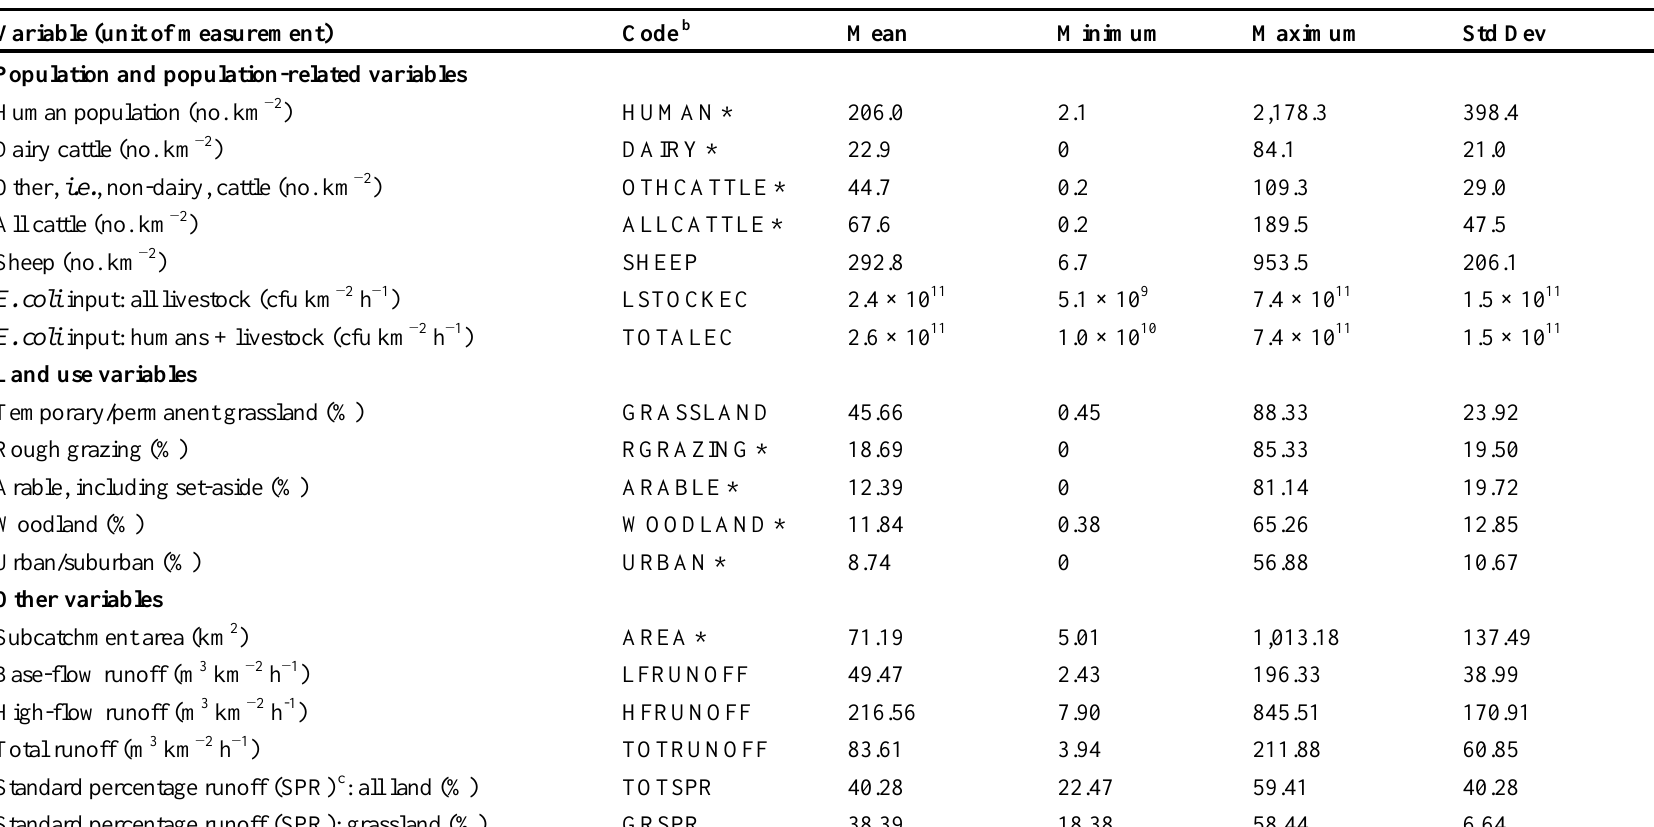
Table 3. Independent variables a used in regression models to predict variations in log concentrations under base- and high-flow conditions, and summary statistics for the 153 subcatchments used in the modelling. Variable (unit of measurement) Code b Mean Minimum Maximum Std